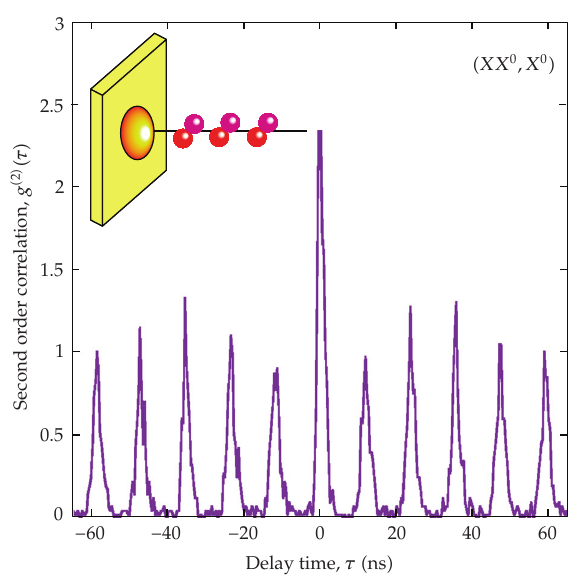
Figure 4: Second-order correlation function obtained with (cid:5) start, stop (cid:6) (cid:8) (cid:5) XX 0 , X 0 (cid:6) configuration. In this case, photon bunching behavior is clearly observed at delay time τ (cid:8) 0. This indicates that the cascaded two-photon emission XX 0 → X 0 per single excitation event is taking place as illustrated by the inset.